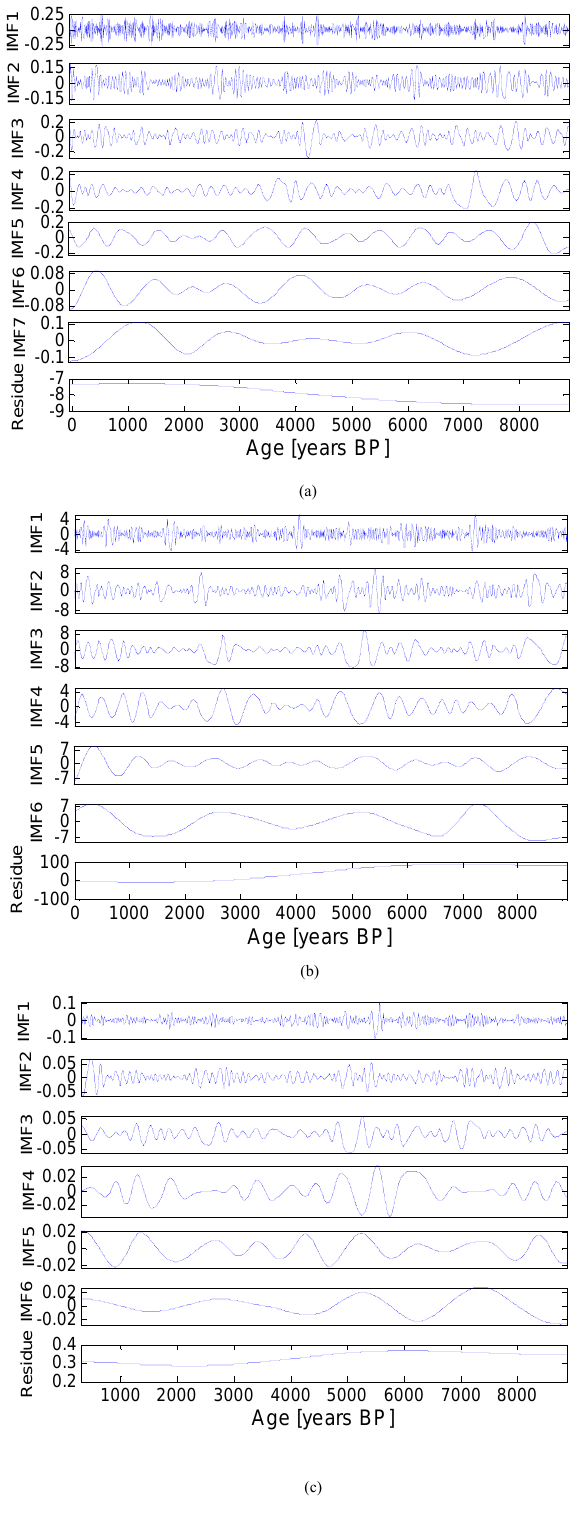
Fig.3 Fig. 3. EMD analysis of δ 18 O (a) , 1 14 C (b) and 10 Be (c)